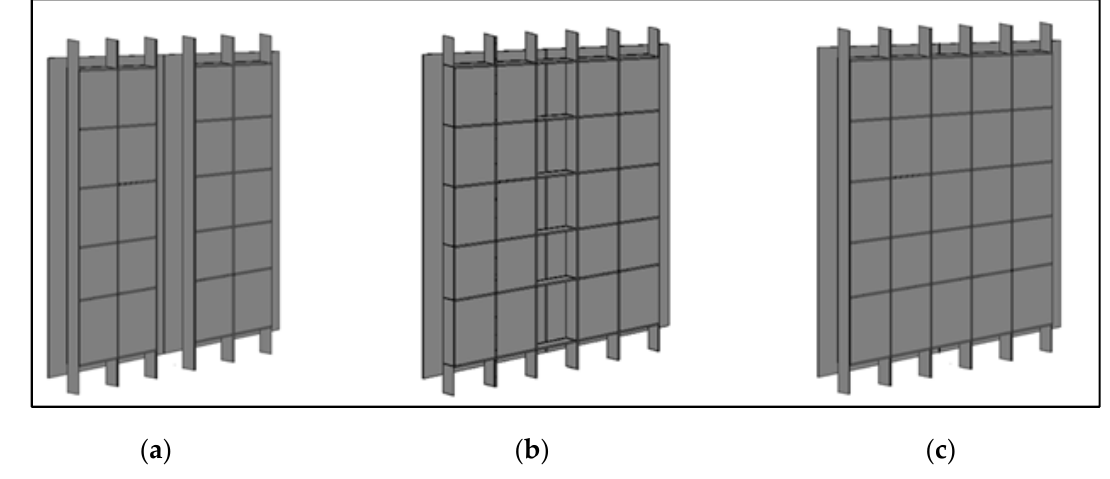
Figure 20. ( a ) Internal welding; ( b ) Horizontal stiffening; ( c ) External panels.